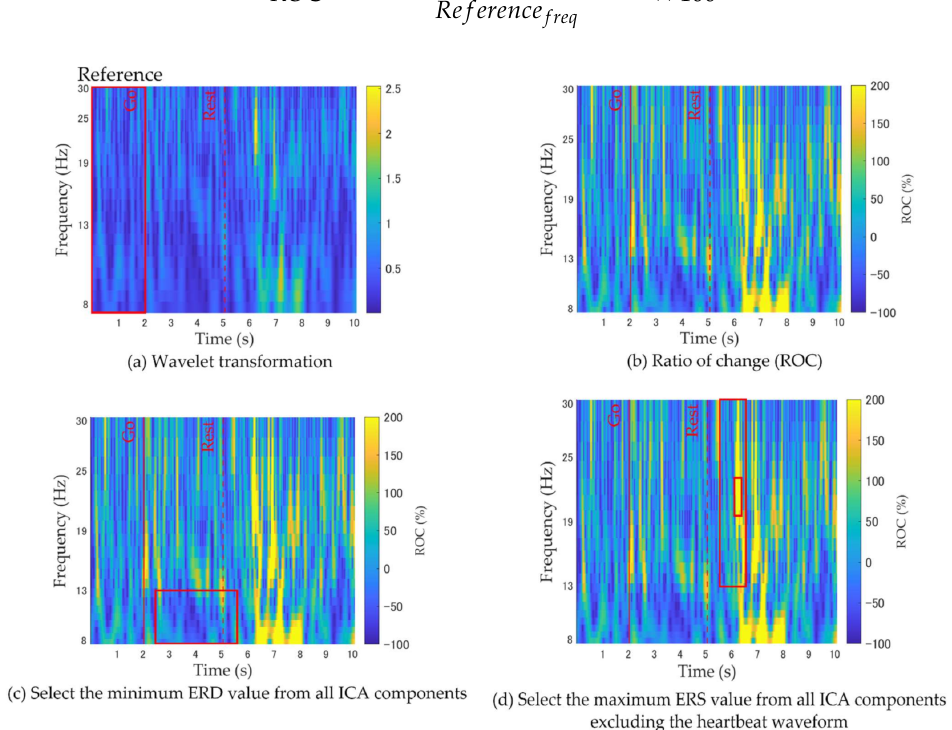
Figure 3. Flow of ERD and ERS calculation. ( a ) the wavelet-transformed data. ( b ) For the wavelet- transformed data, the rate of change from baseline (i.e., increase for ERS and decrease for ERD) was calculated using the average value from the reference period (from the preparation cue to the task cue). ( c ) ERD was calculated as the average rate (8–13 Hz) of decrease from 500 ms after the task cue “Go” until 500 ms after the rest cue “Rest”. The component with the lowest ERD value was selected as the ERD-representative component for that trial only. ( d ) ERS was calculated as the average rate (13–30 Hz) of increase from 500 ms after the rest cue “Rest” until 1500 ms after the rest cue “Rest”. The component with the highest ERS value was selected as the ERS-representative component for that trial